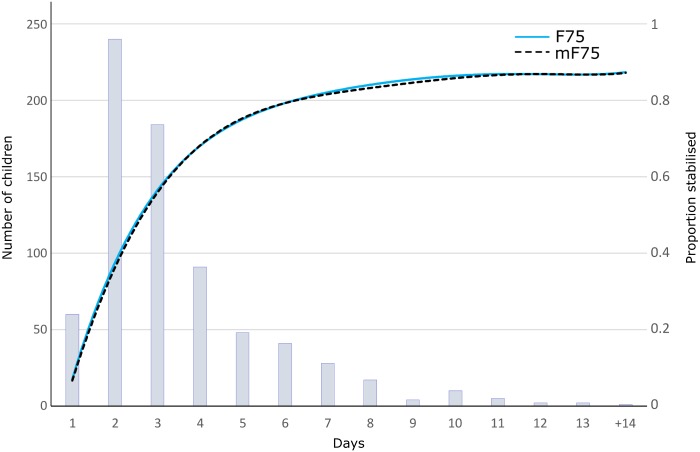
Primary endpoint, time to stabilization.Blue bars indicate the number of children who stabilized each day; the cumulative proportion stabilized allocated to F75 is shown by the blue line and allocated to mF75 by the dashed black line. F75, standard F75; mF75, modified F75.